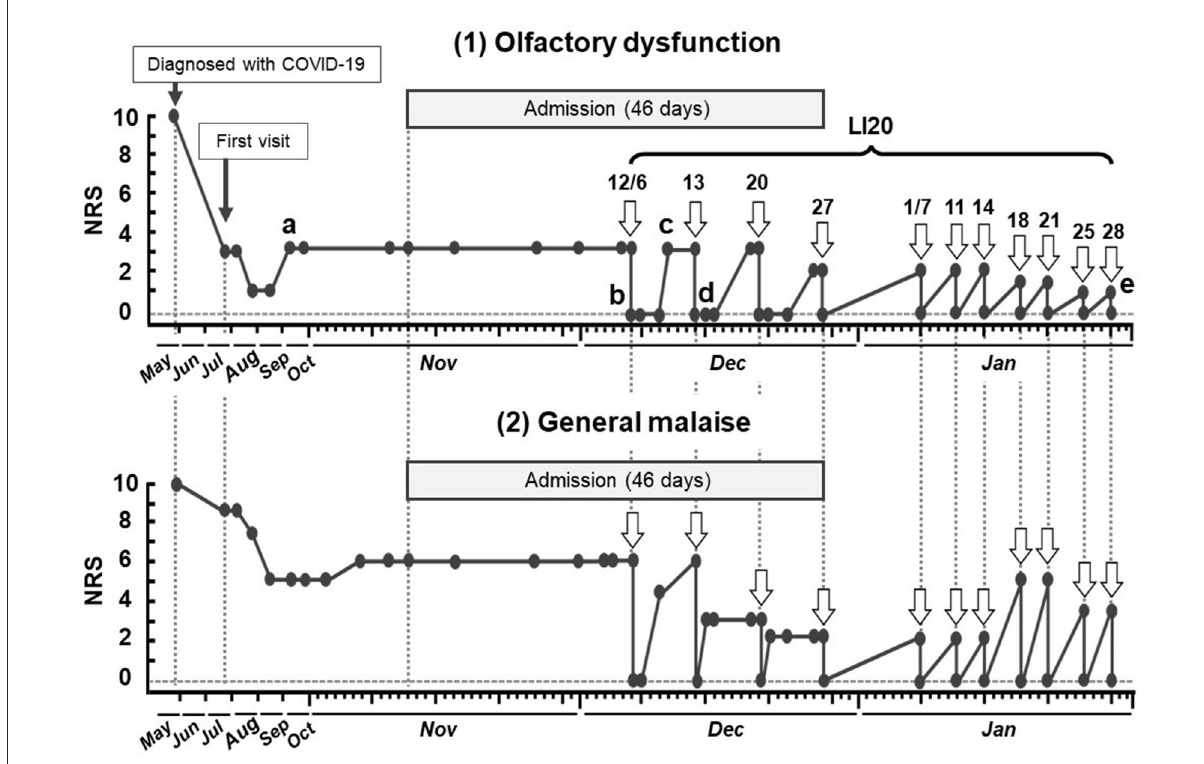
FIGURE3 Timeline of acupuncture treatment and subjective symptoms of olfactory dysfunction and general malaise in case 2. a. Cannot recognize the smell of coffee. b. Recognizes the smell of alcohol, mayonnaise, and soy sauce in the room. c. Cannot recognize the smell of coffee. d. Can smell toothpaste. e. The smell of coffee is noticeable. NRS, numeric rating scale; COVID-19, coronavirus